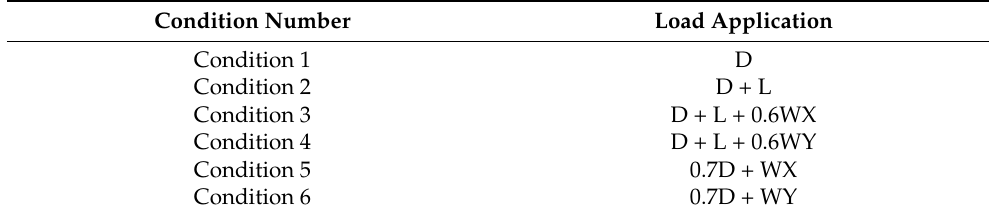
Table 1. Load on the truss due to various working